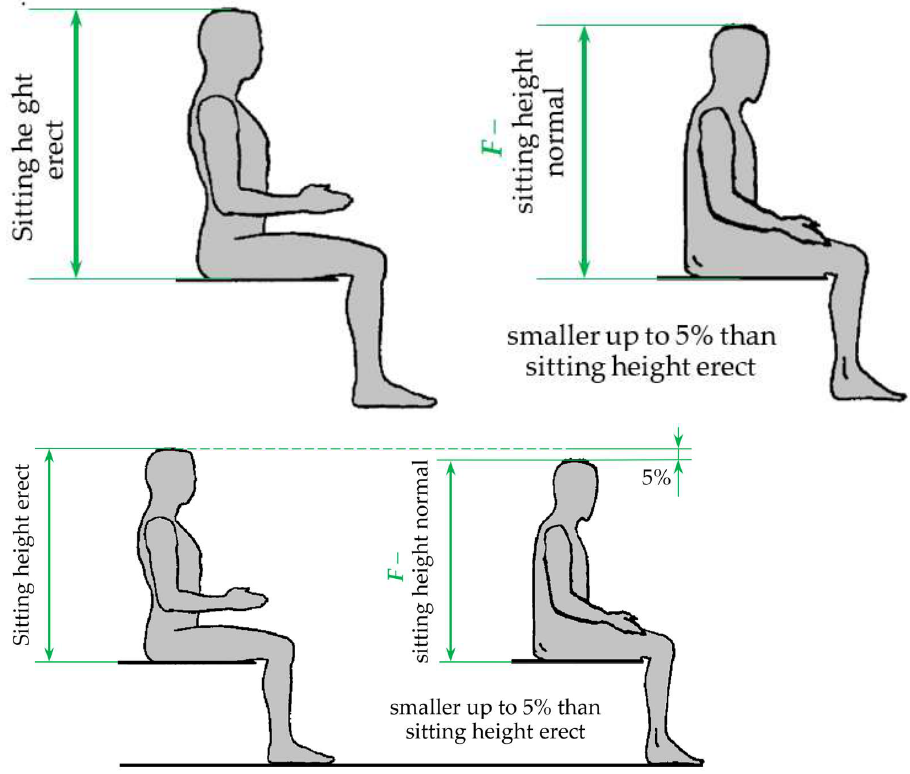
Figure 9. Sitting height erect versus sitting height normal.